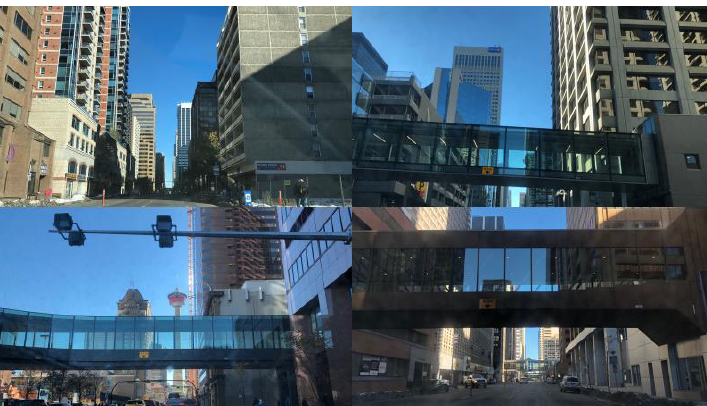
Figure 13. Test environment in an urban area: In this test, the environment was typical urban canyon with buildings along the road and sky bridges from time to time.